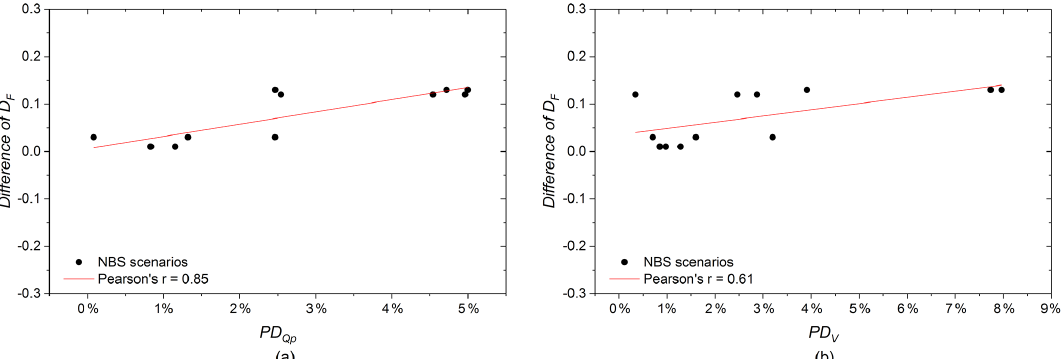
Figure 16. (a) Relationship between the difference in D F of the same types of NBS scenarios and PD Qp of the same types of NBS scenarios. (b) Relationship between the difference in D F of the same types of NBS scenarios and PD V of the same types of NBS